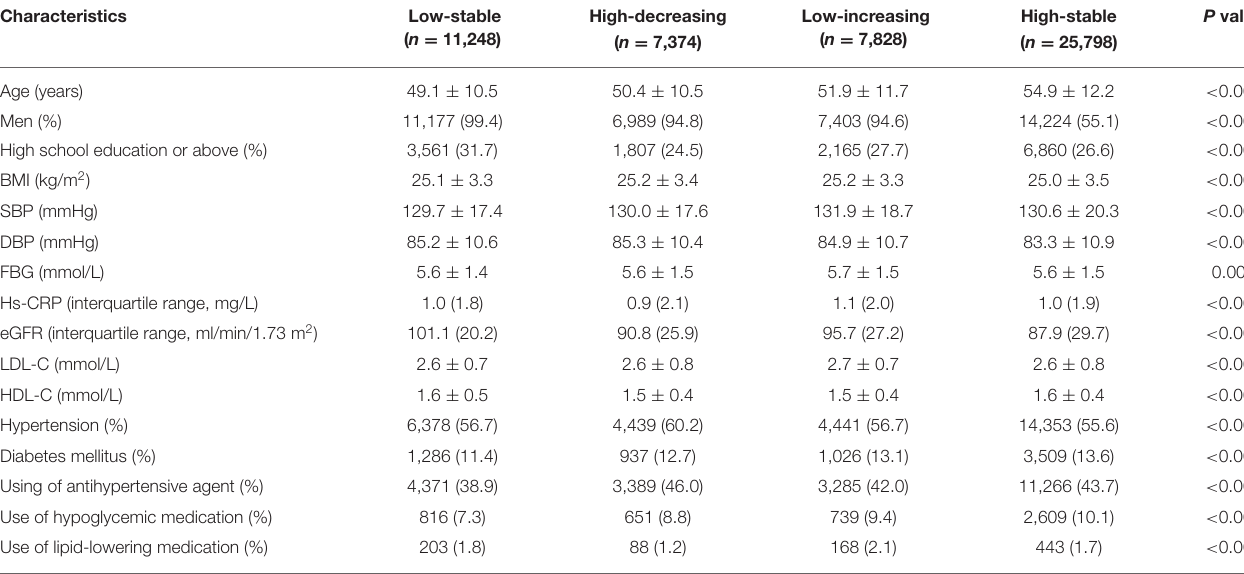
TABLE 1 | Characteristics of 52,248 participants according to healthy lifestyle score trajectories from 2006 to 2010.